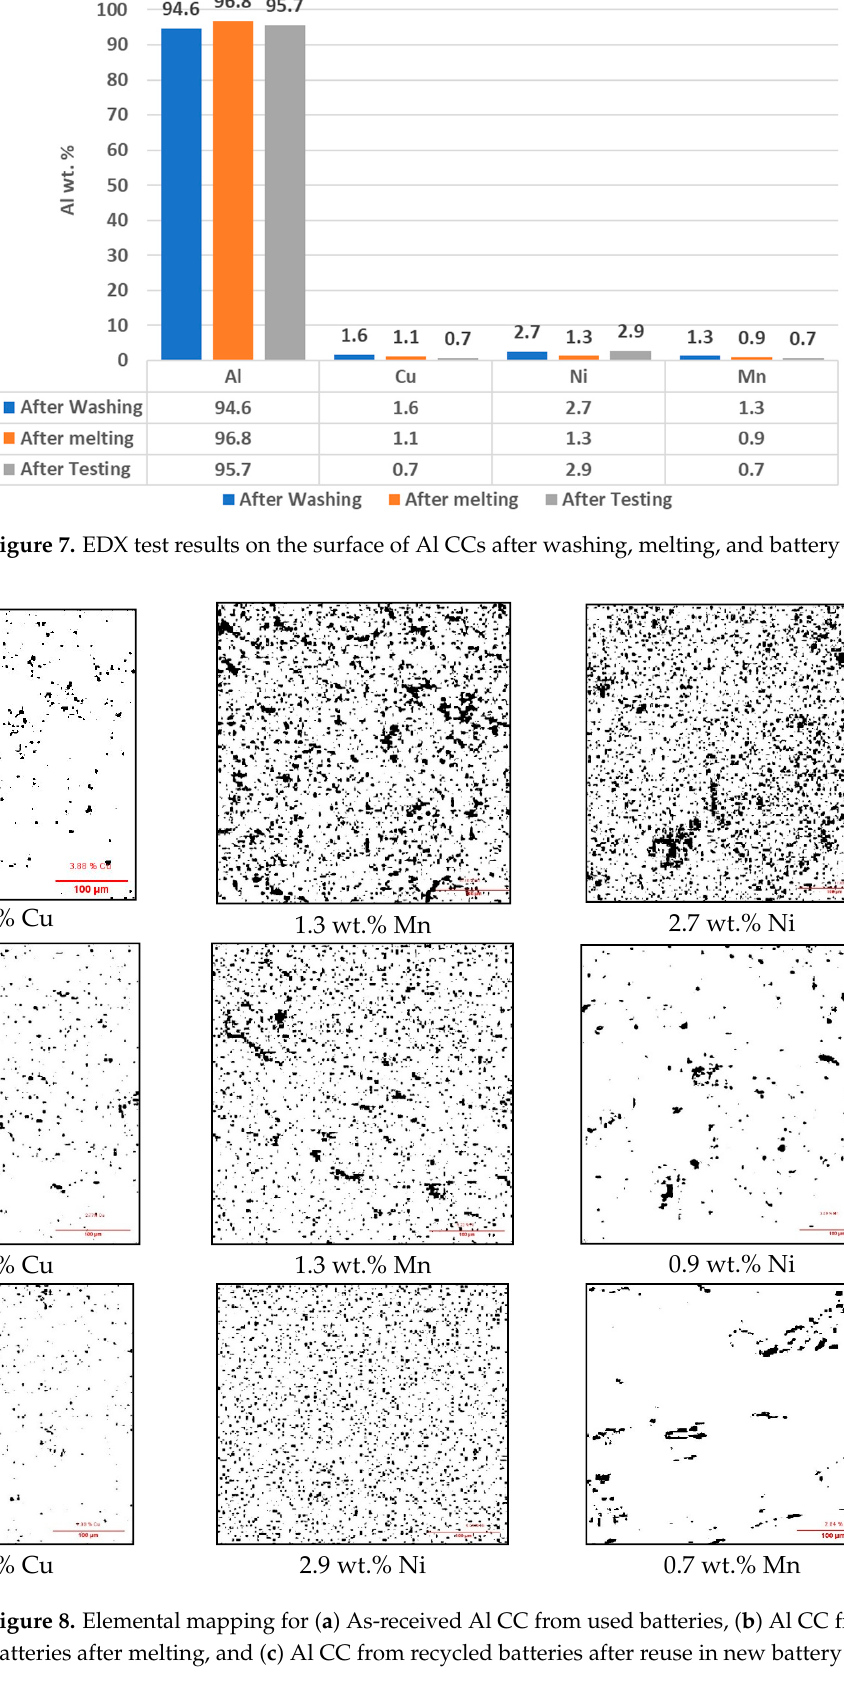
Energies 2022 , 15 , x FOR PEER REVIEW